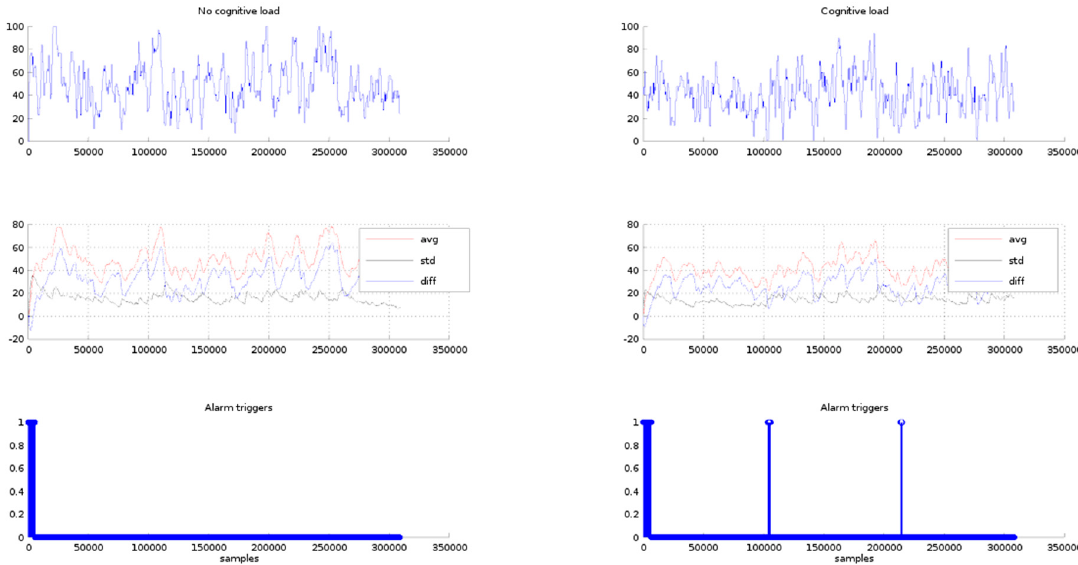
Figure 11. Row 1, P1 EEG signals for the no cognitive load and cognitive load. Row 2, average, standard deviation and difference of the EEG signal values. Row 3 alarm triggers for difference values of less than 10 units.